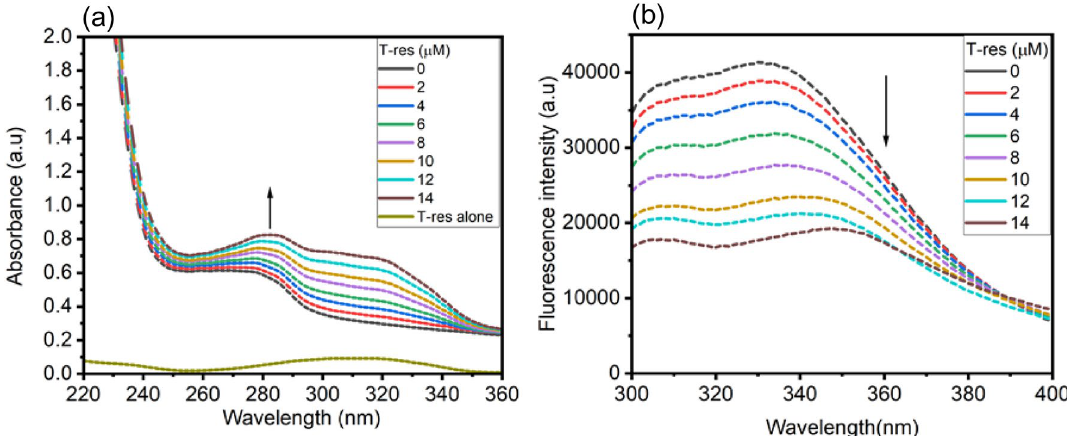
Figure 2. (a) UV-absorption spectrum of HSA (5 µM), and (b) fluorescence emission spectrum of HSA (5 µM) in the presence of an increasing concentration of trans -resveratrol (0–14 µM) at 298.15 K and pH 7.4. λ ex of HSA = 280 nm. The concentration of trans -resveratrol alone is 2 µM.